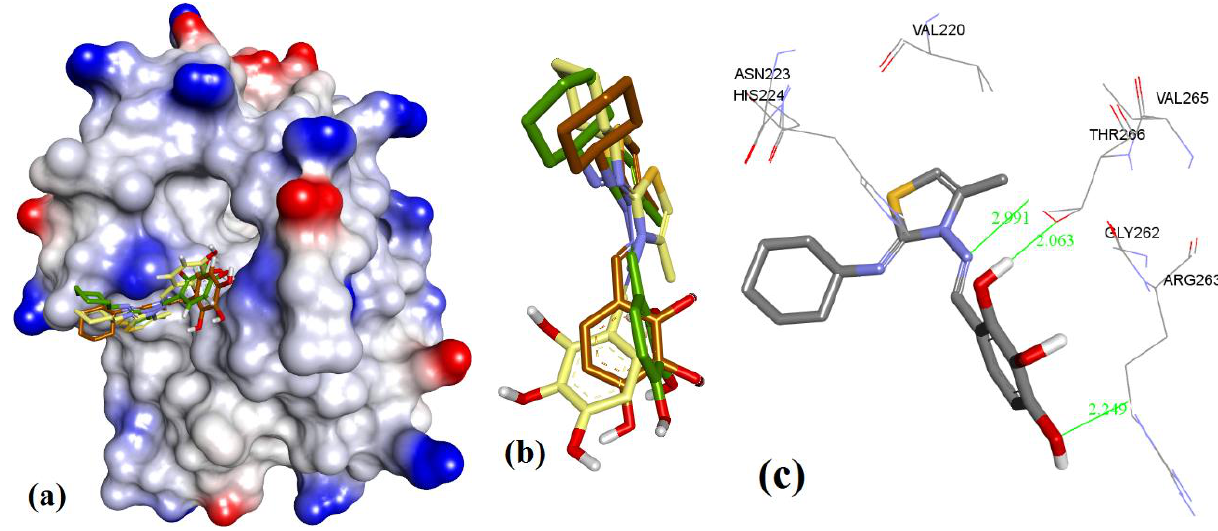
Figure 19. ( a ) The ionized solvent-exposed surface mapping of hMcl-1 along with the docked poses of MIM1 from MOE (in brown), AutoDock (in green), and VlifeDock (in yellow) show their fitting to the cavity. ( b ) Similar-pose ensemble clustering of all three poses attained from the three different docking methods. ( c ) Binding mode of MIM1.